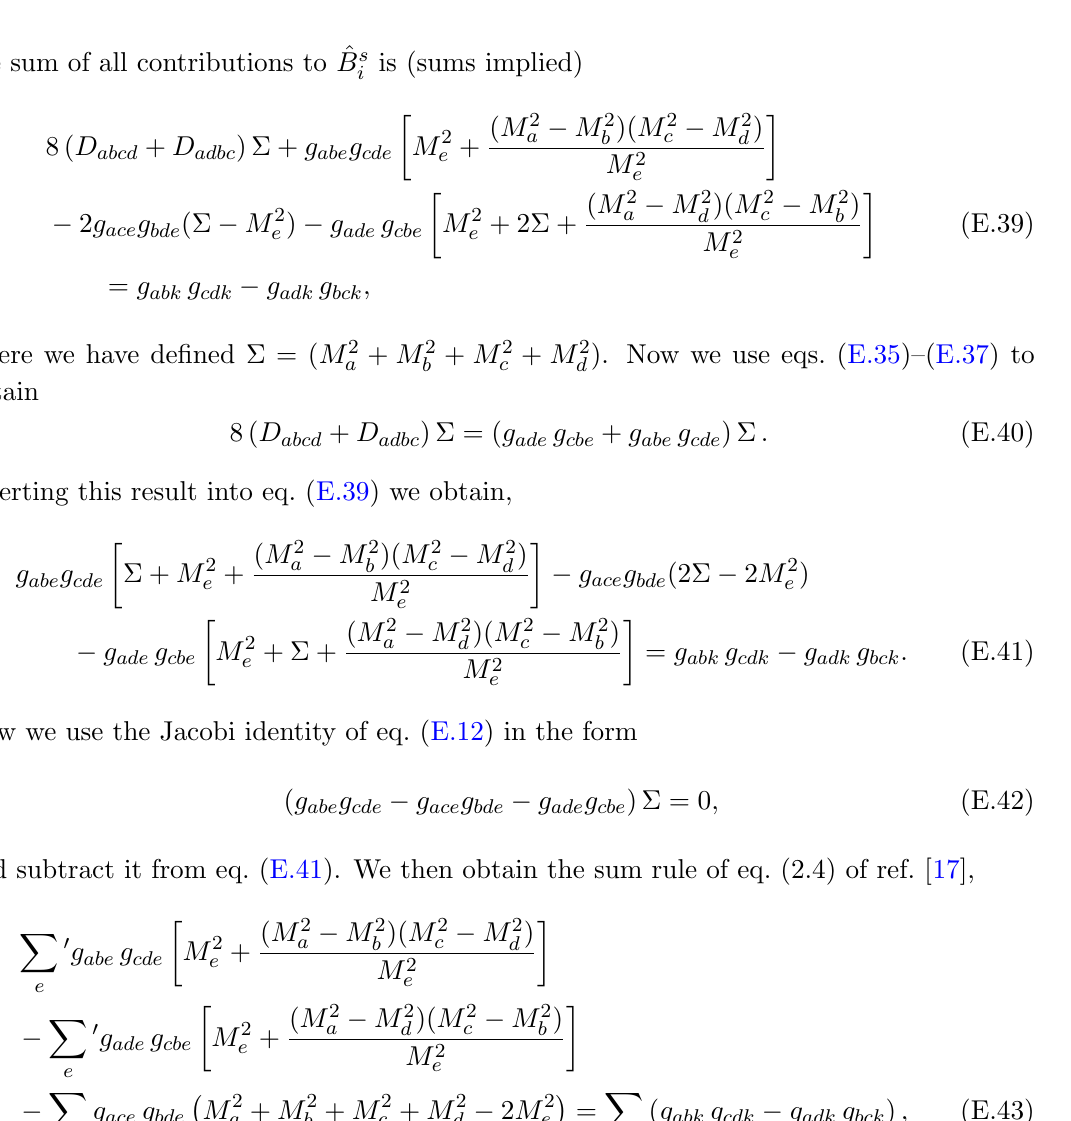
+ M 2 + M 2 + M 2 a c b d